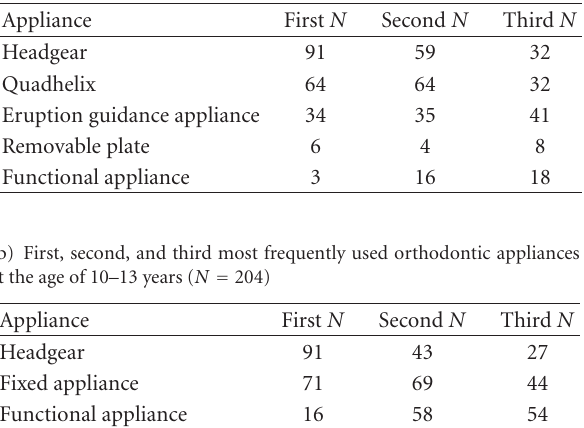
Table 2: The appliances mentioned as the first, second, and third most frequently used appliance in the age groups 7–9 and 10–13